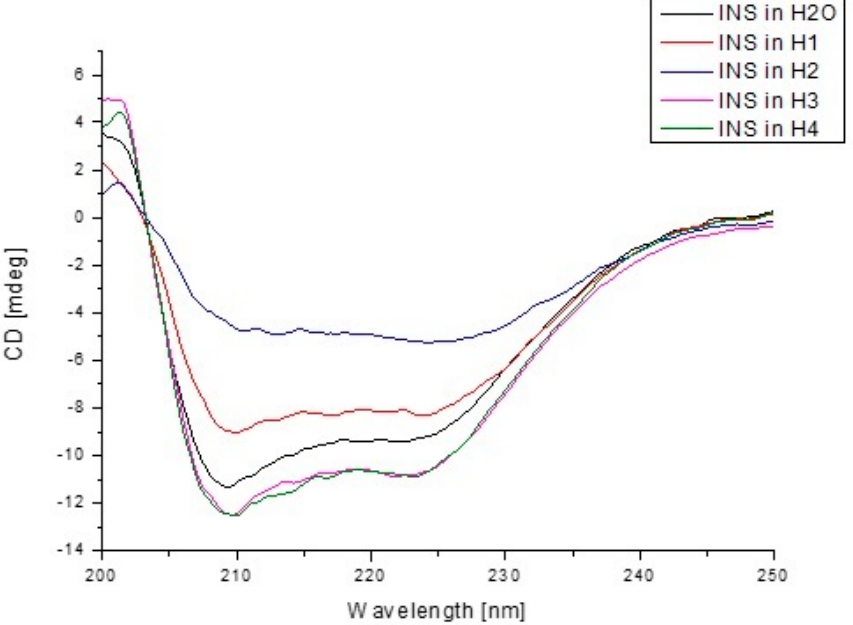
Figure 8. Far-UV circular dichroism spectra of insulin in the presence of H 2 O and model hydrogels. Table 7. The percentage (%) content of the secondary structure elements of insulin based on Reed’s reference model. Form of Insulin